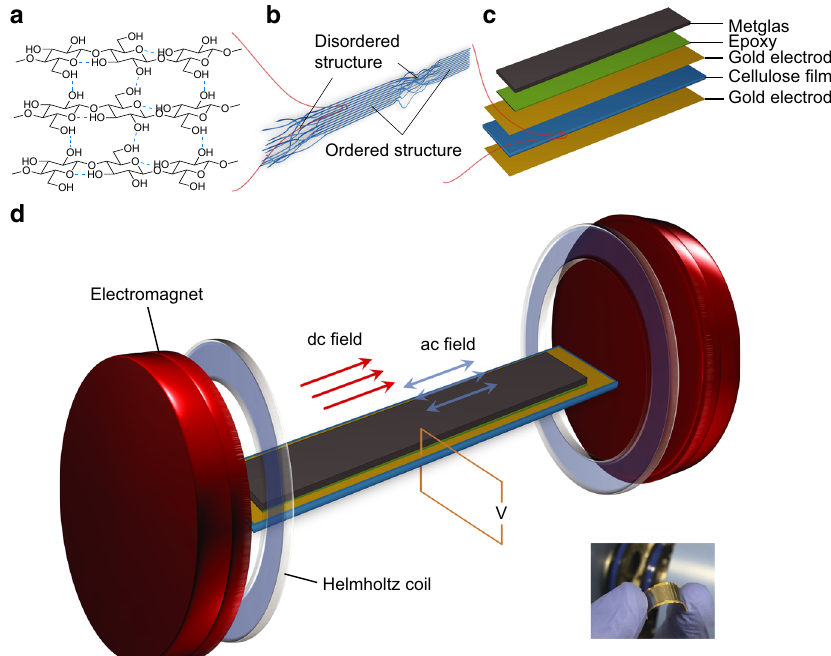
Fig. 1 Cellulose ME laminate and the experimental set-up of ME effect measurement. a Scheme of cellulose crystal II, the most common crystalline type in regenerated cellulose materials. The saccharide unit provides dipolar segments along the aligned fi bril thus rendering the piezoelectric nature. b Illustration of cellulose fi bril alignment at the cross-section of cellulose fi lm. Part of the ordered structure provides crystalline properties. c Schematic of cellulose- based ME laminate structure. The thickness is measured as 19 ± 2 µ m for hot-press fi lm and 27 ± 3 µ m for the control fi lm by using a micrometer caliper. The cellulose fi lms are fi rst sputter coated with 50 nm thick gold electrodes on both sides and then glued with Metglas 2605 SA1, of which the thickness is 25 µ m. To ensure even distribution, the epoxy is preheated to 60 °C to improve the liquidity. d Schematic view of the bulk system for ME voltage measurement. The output voltage is collected from the interface gold electrodes and monitored as root mean square values using a lock-in ampli fi er. The inset below shows the picture of the fi nal cellulose ME laminate used in the